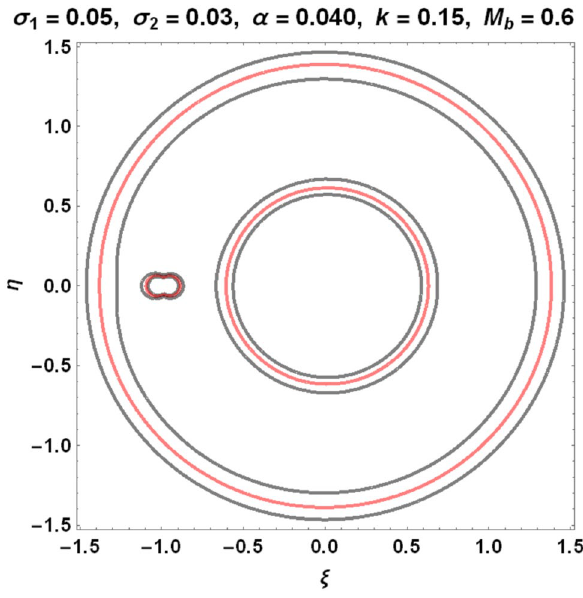
= 0.01215, e = 0.0549, a = 1.000453, A = 0.0000003686, T = 0.01, Figure 5. Zero velocity curves for µ σ 1 = 0.05, σ 2 = 0.03, α = 0.040, k = 0.15, M b = 0.6 showing the boundary